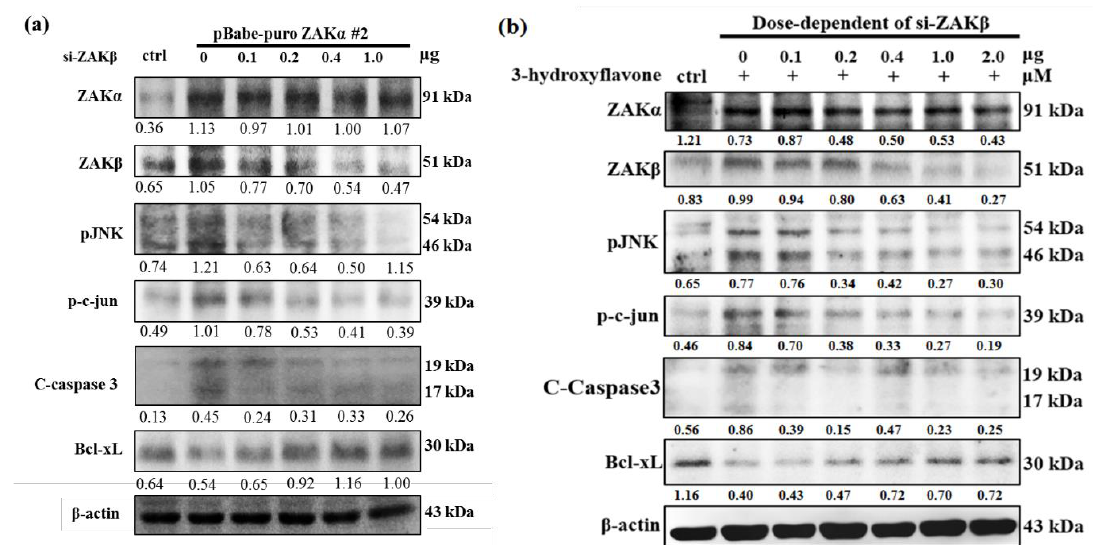
Figure 4. Role of ZAK transcriptional variants and the e ff ect of 3-HF on ZAK β and ZAK α . ( a ) Western blot analysis of the expression of ZAK, pJNK, p-c-Jun, apoptotic protein C-Caspase 3, and survival protein Bcl-xL with siZAK β by transient transfection for 24 h in a dose-dependent manner (0–1.0 µ g / mL) in a stable clone cell line expressing ZAK α . ( b ) Western blot analysis of the expression of ZAK, pJNK, p-c-Jun, apoptotic protein C-Caspase 3, and survival protein Bcl-xL with siZAK β by transient transfection for 24 h in a dose-dependent manner (0–2.0 µ g / mL) following 3-HF treatment in human OS cells.